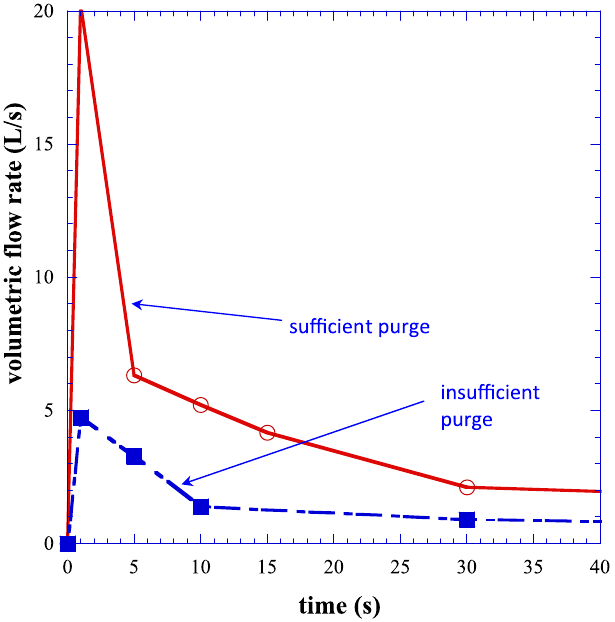
FIG. 24. (Color) SF 60